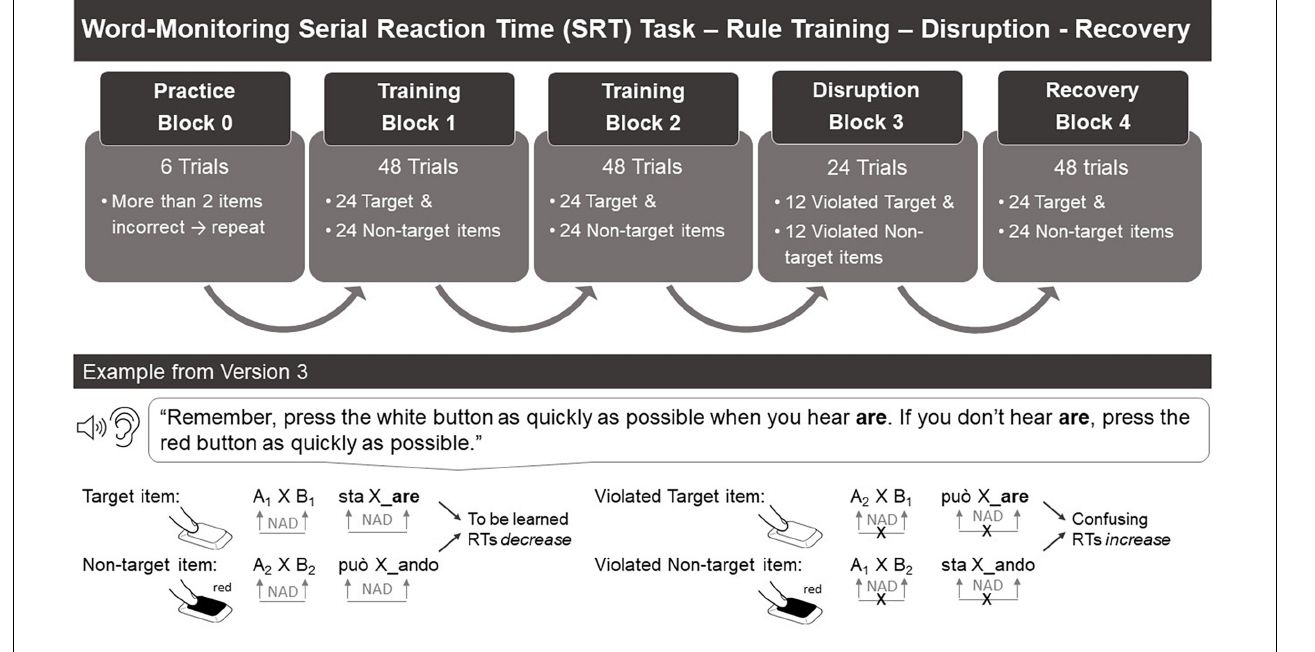
FIGURE 1 | Block types within word-monitoring SRT task, trial and item distribution, and an example draft of the